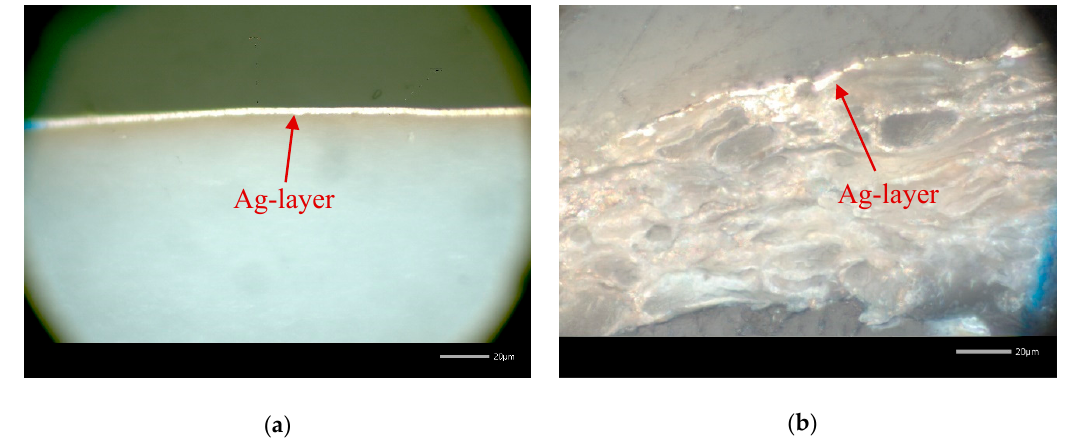
Figure 6. Microscopic images (50×) of the cross section of the printed, cured and sintered Ag-layer on PET ( a ) and type 4 ( b ) paper substrate; the size bar corresponds to 20 µm.